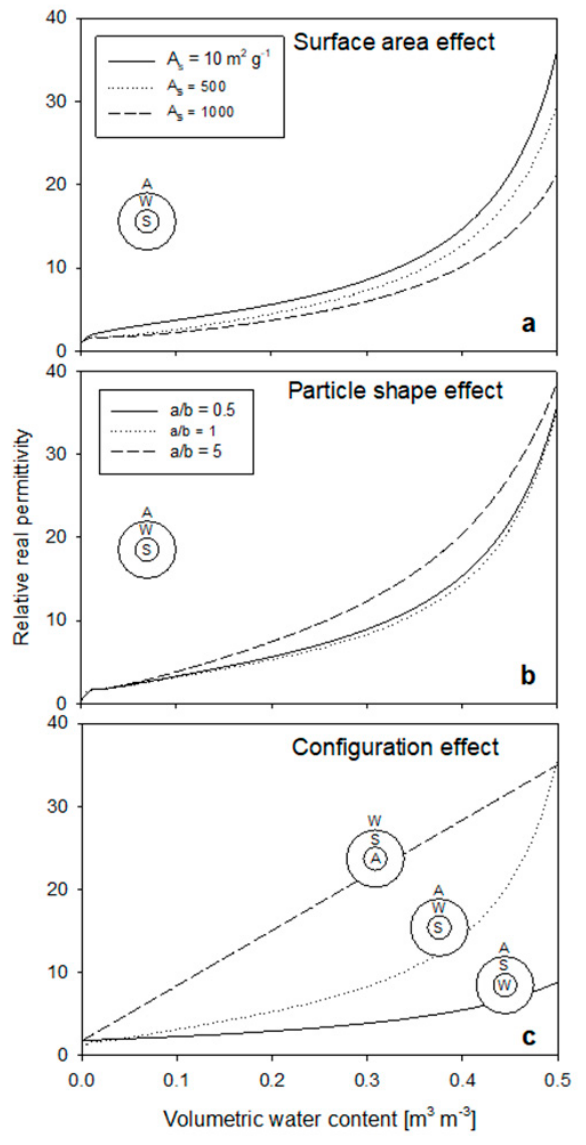
Figure 12. Three-phase confocal ellipsoid model (see [11] for details) demonstrating the influence of ( a ) surface area and ( b ) particle shape using a solid-water-air (SWA) configuration and demonstrating the influence of ( c ) phase configuration on the modeled permittivity.